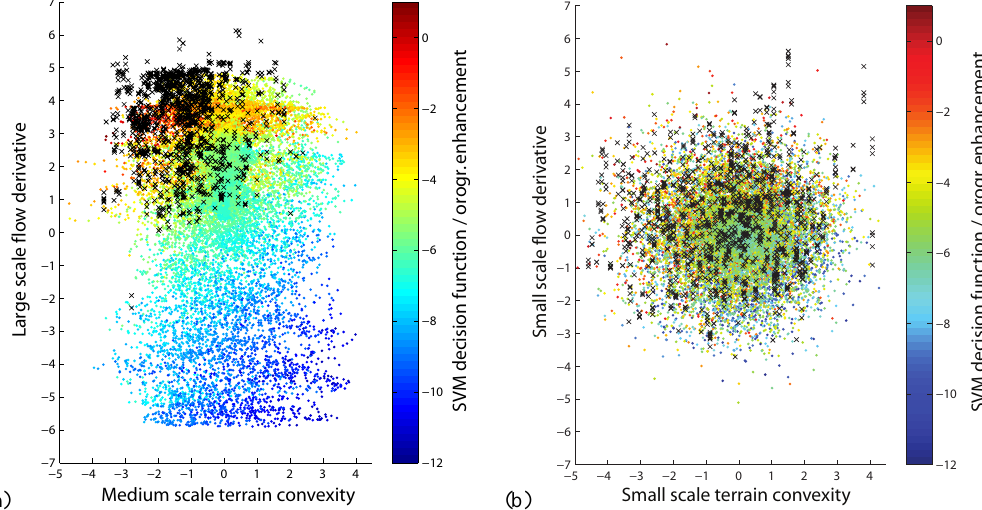
Figure 3. (a) Scatterplot of the orographic class (black crosses) in the space of features medium scale terrain convexity and large scale flow derivative. The SVM decision function is computed on the whole grid of Fig. 2b and is here displayed with the same colour scale. Orographic enhancement increases from the bottom right corner (valley bottom, leeward side of Alps) to the top left corner (hill top, windward side of Alps). (b) Same as (a) but with features smallest scale terrain convexity and smallest scale flow derivative. No patterns can be seen in this combination of features which is also neglected by the